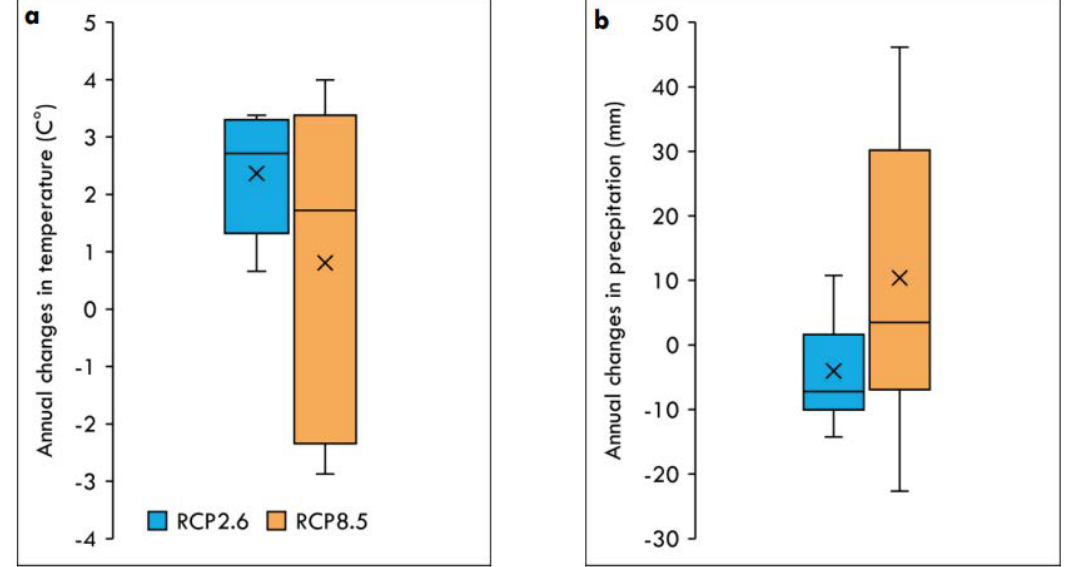
Figure 3. Temperature and precipitation variations during the soybean growing season in 2020–2039 compared to 2011 . ( a ) Variations in annual temperature in ◦ C. ( b ) Variations in annual precipitation in mm. Crosses indicate the mean; solid lines inside the box the median; top and bottom of the box the 25th and 75th percentiles, and whiskers the minimum and maximum. Source: Extracted from ISI-MIP [10] publicly available dataset.